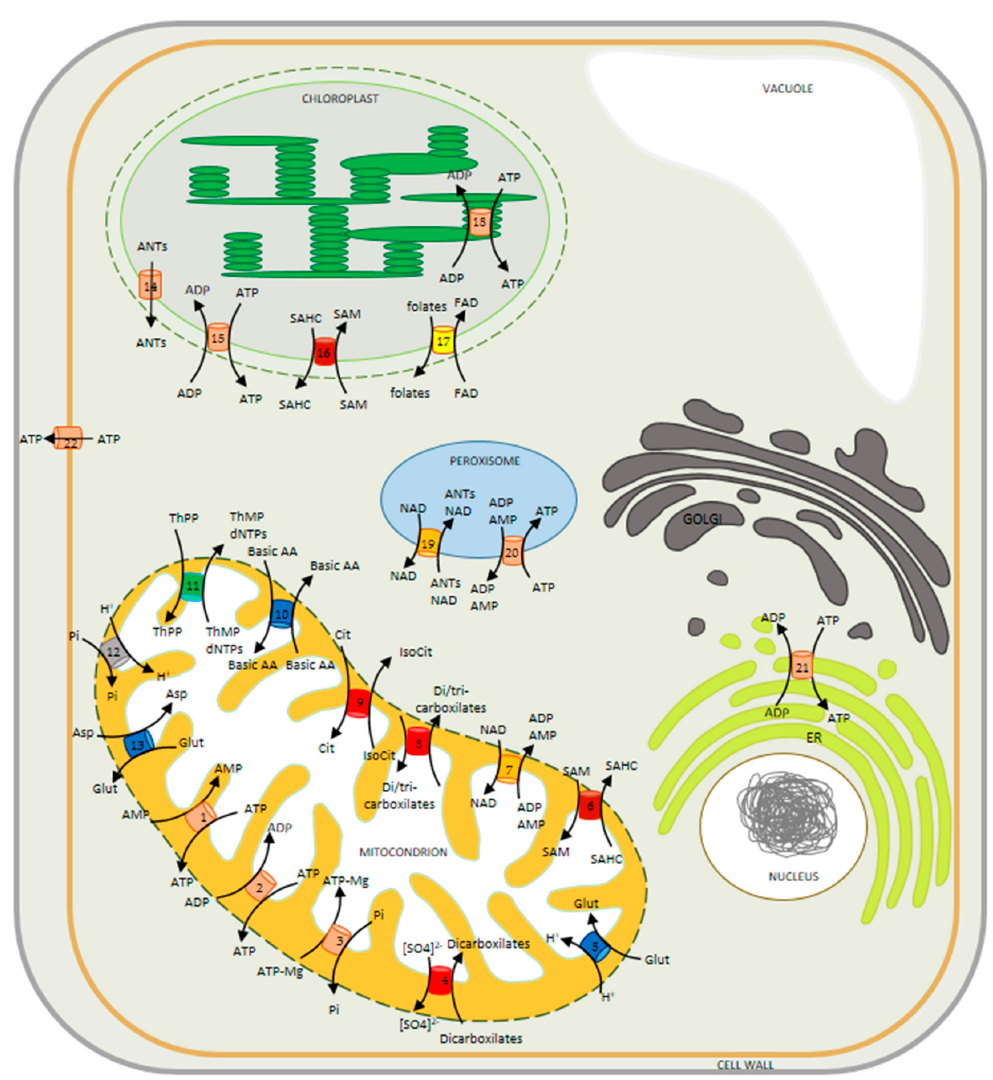
Figure 2. Figure 2. Model illustrating the mitochondrial carriers described and characterized in plant cells. All carriers belong to the mitochondrial carrier family (MCF). Carriers localized in the inner inner mitochondrial membrane: (1) ATP / AMP carrier, ADNT1; (2) ATP / ADP carriers, AACs; (3) AMP-ADP-ATP / Pi carriers, APCs; (4) dicarboxylate carriers, DIC1-3; (5) glutamate-H + carrier,